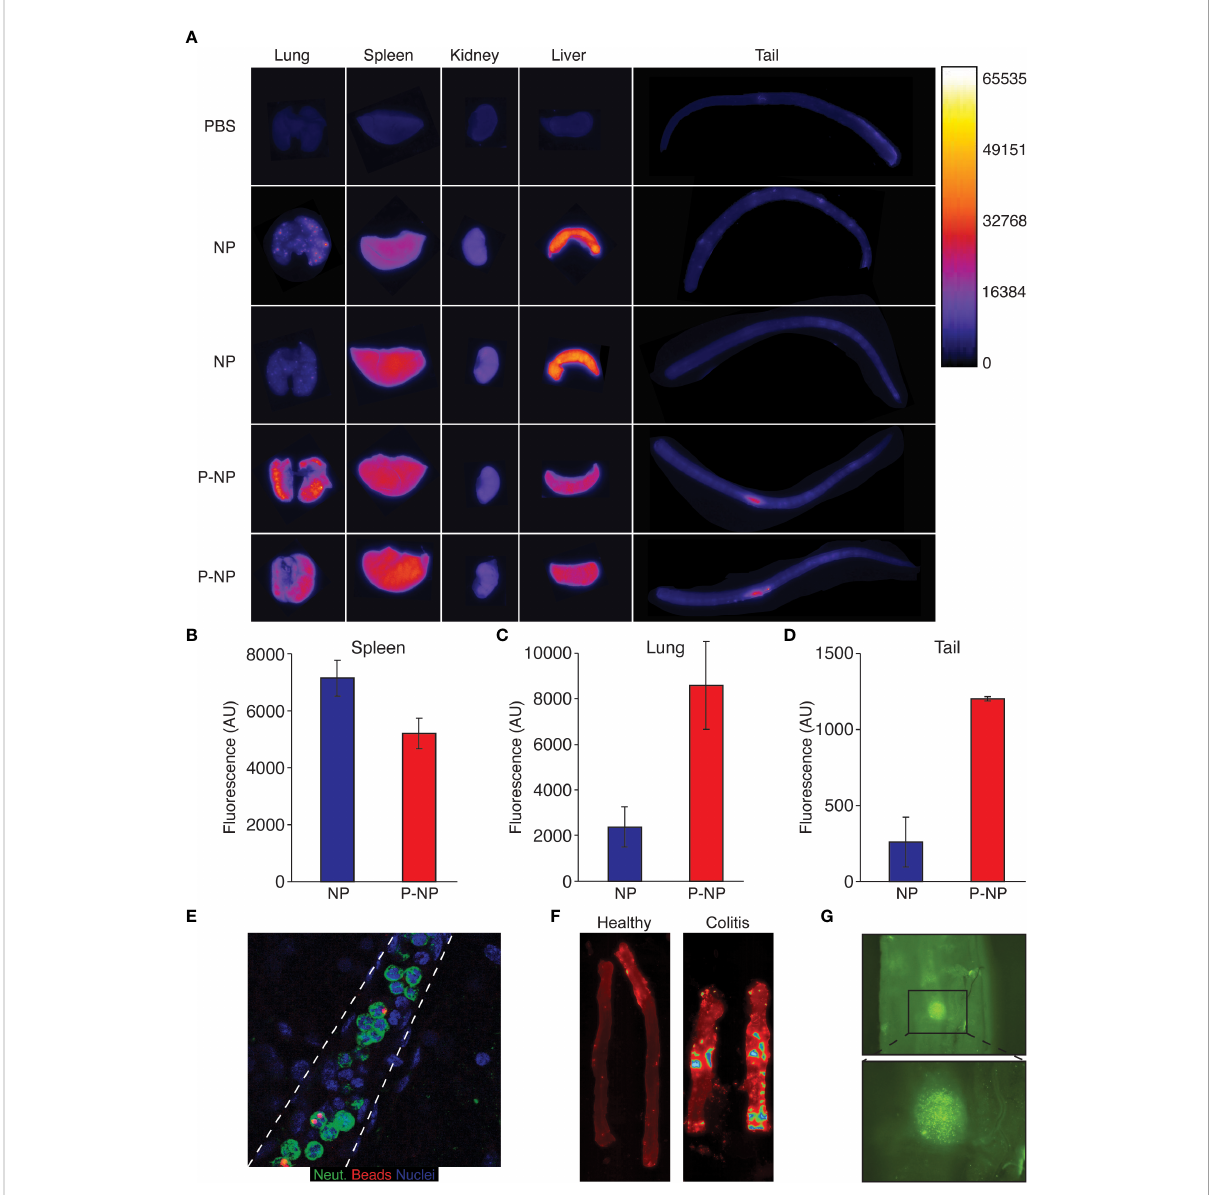
FIGURE 3 Nanoparticle distribution in vivo. For biodistribution experiments we used Cy3 + -streptavidin nanobeads which were either administered as naked nanobeads (NB) or following labelling with the LQI neutrophil targeting peptide (P-NB). (A) Typhoon ™ biodistribution imaging in healthy Balb/C mice 3 hours following i.v. injection of either Cy3 + NB, Cy3 + P-NB or PBS as control. The mice were sacri fi ced and their organs imaged immediately. (B-D) Quanti fi cation of Typhoon Cy3 fl uorescence reading from the spleen (B) , the lungs (C) and the tail (D) of mice injected with either NB or P-NB/ (E) Fluorescent staining of a neutrophils (green) carrying fl uorescent nanobeads (red) within a blood vessel (dashed lines). (F) Representative Typhoon ™ imaging of Cy3 + P-NB in colons from healthy mice (left) and mice with DSS-induced colitis (right). The mice were sacri fi ced 3 hours following i.v. injection Cy3 + P-NB, the colon harvested, washed with PBS and imaged immediately. (G) Representative imaging taken with a fl uorescent binocular showing the accumulation of P-NB the in fl amed colon from mouse with DSS-induced colitis. Following the induction of colitis, the mouse was injected with Cy3 + P-NB, the colon harvested, washed with PBS and imaged immediately. Error bars represent ±